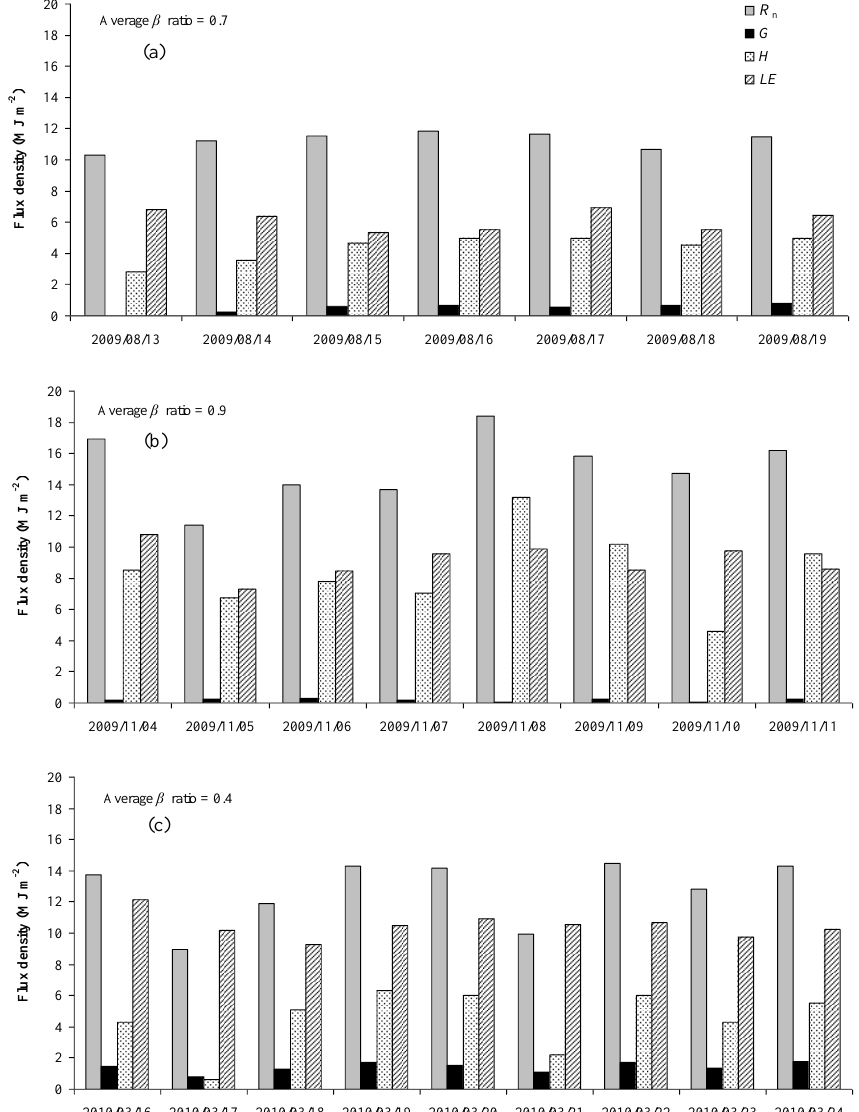
Figure 6. Daily total energy densities (while R n >0) measured at the Nkazana Swamp Forest in (a) August 2009, (b) November 2009 and (c) March